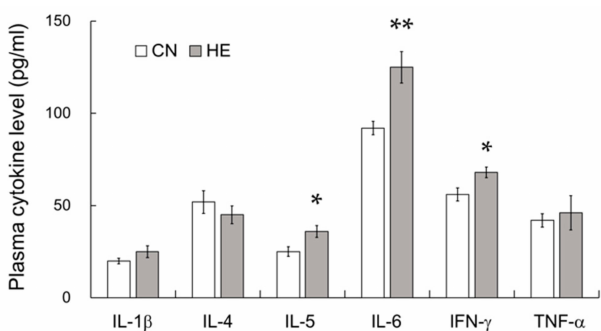
Figure 4. Plasma cytokine levels of control (CN) and heat-exposed (HE) rats. Plasma interleukin (IL)-1 β , IL-4, IL-5, IL-6, interferon- γ (IFN γ ), and tumor necrosis factor- α (TNF α ) levels in the CN and HE groups. Plasma IL-5, IL-6, and IFN γ expression was significantly higher in the HE group than in the CN group. Values are presented as the mean ± SEM ( n = 8 in each group). * p < 0.05, ** p < 0.01, significant di ff erence between the CN and HE groups.